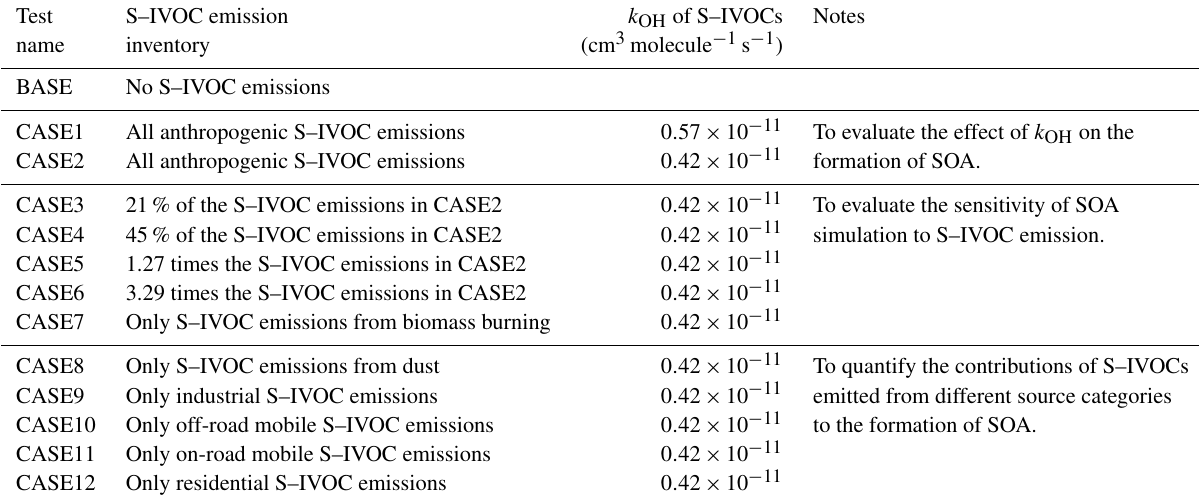
Figure 8. Spatial distribution of temporal average (a) SOA and (b) SI-SOA during the study period over the modeling domain in the CASE2 run. Table 5. Overview of